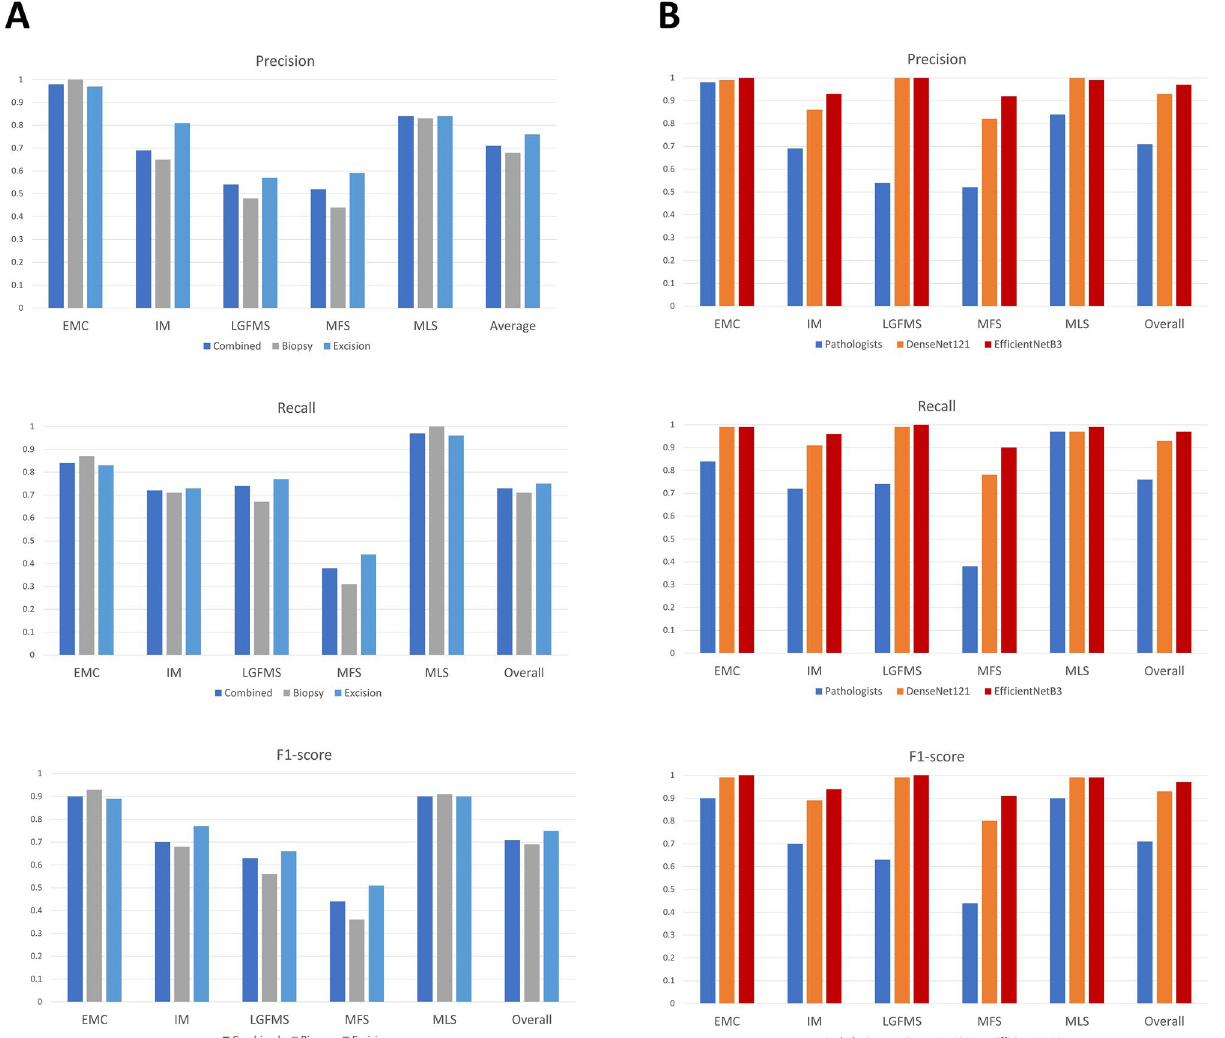
Figure 3. The precision, recall and F1-score for different diagnostic categories of pathologists ( A ) and the deep learning models ( B ). EMC extraskeletal myxoid chondrosarcoma, IM intramuscular myxoma, LGFMS low grade fibromyxoid sarcoma, MFS myxofibrosarcoma, MLS myxoid